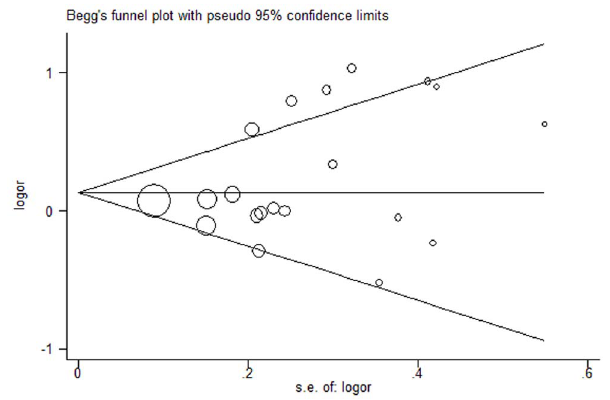
Figure 3. Funnel plot for the detection of the publication bias in this